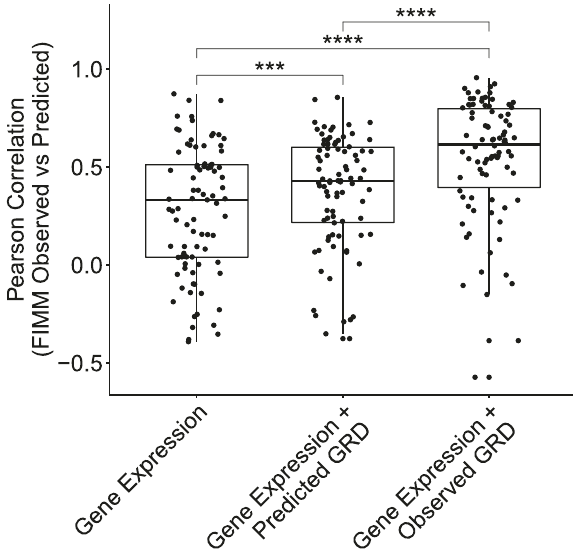
Fig. 4 Expression-based predictions of drug response indicate concordance of independent ex vivo datasets and may be improved by incorporating general response across drugs. Performance (Pearson correlation between observed and model- predicted drug response; y axis) of ridge regression models trained on OHSU data and tested on FIMM data using genes as predictors (Gene Expression), genes and GRD predicted by applying ridge regression to gene expression (Gene Expression + Predicted GRD), or genes and GRD calculated from drug response data (Gene Expression + Observed GRD). Each point corresponds to a drug ( n = 87). Drug d is excluded from observed and predicted GRD in modeling d ’ s response. ****One-sided paired Wilcoxon signed rank p < 0.0001; *** p <